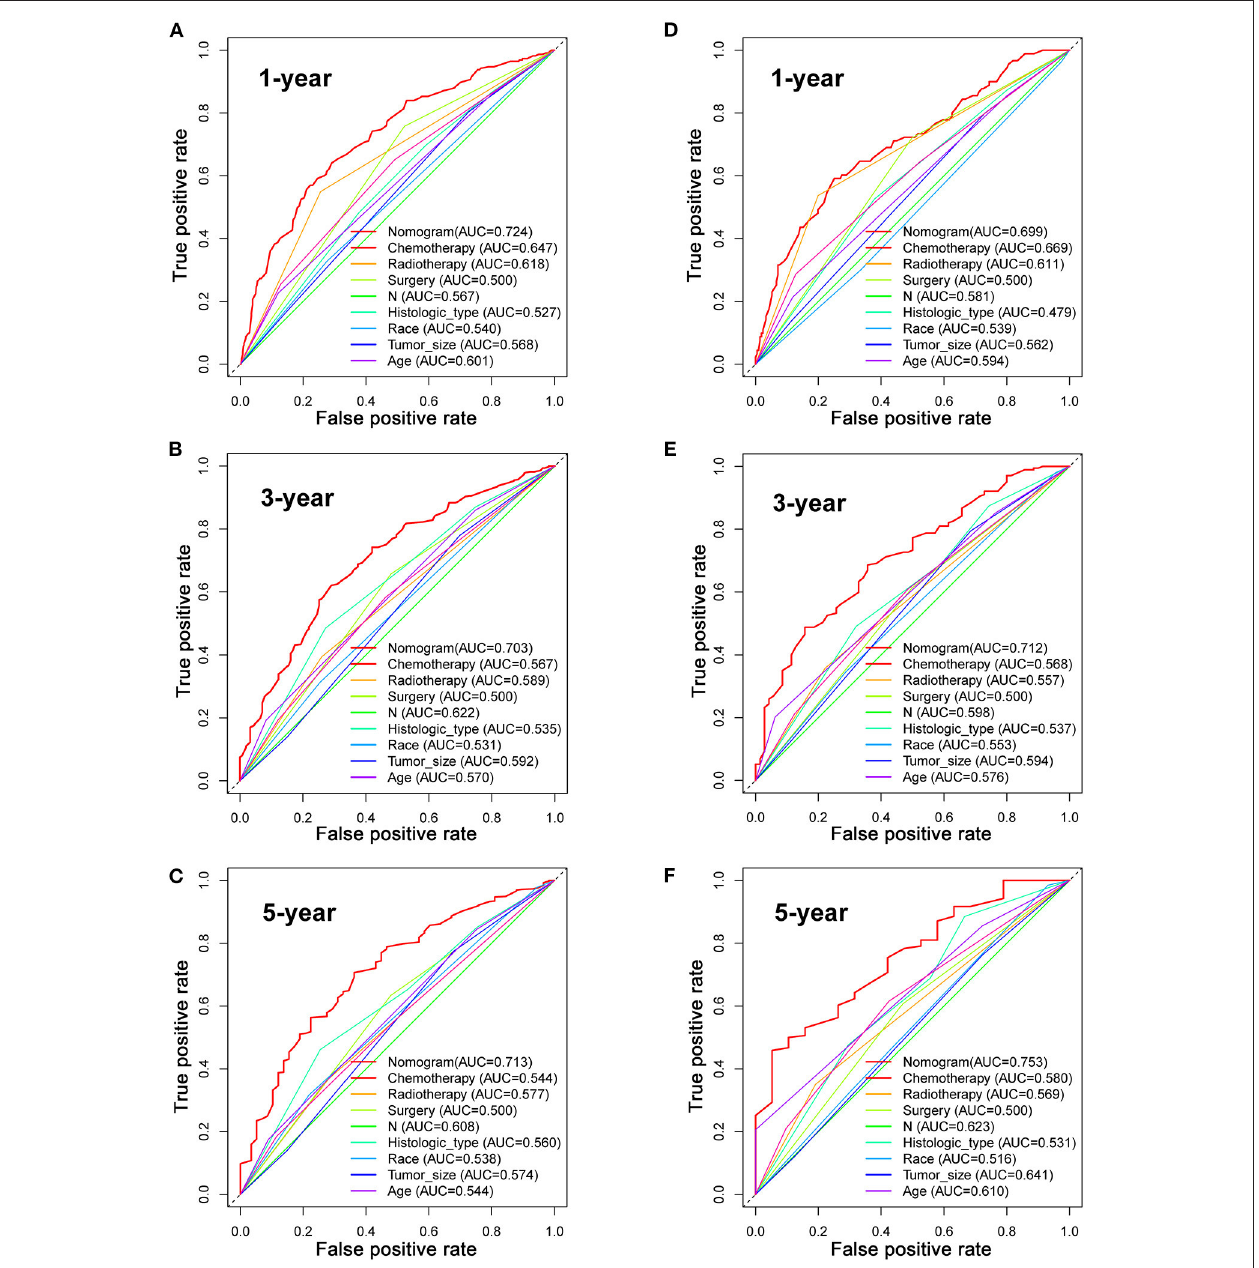
FIGURE 4 | The ROC curves for predicting patients’ CSS of nomogram and all independent predictors at 1 (A) , 3 (B) , and 5 years (C) in the training cohort and at 1 (D) , 3 (E) , and 5 years (F) in the validation